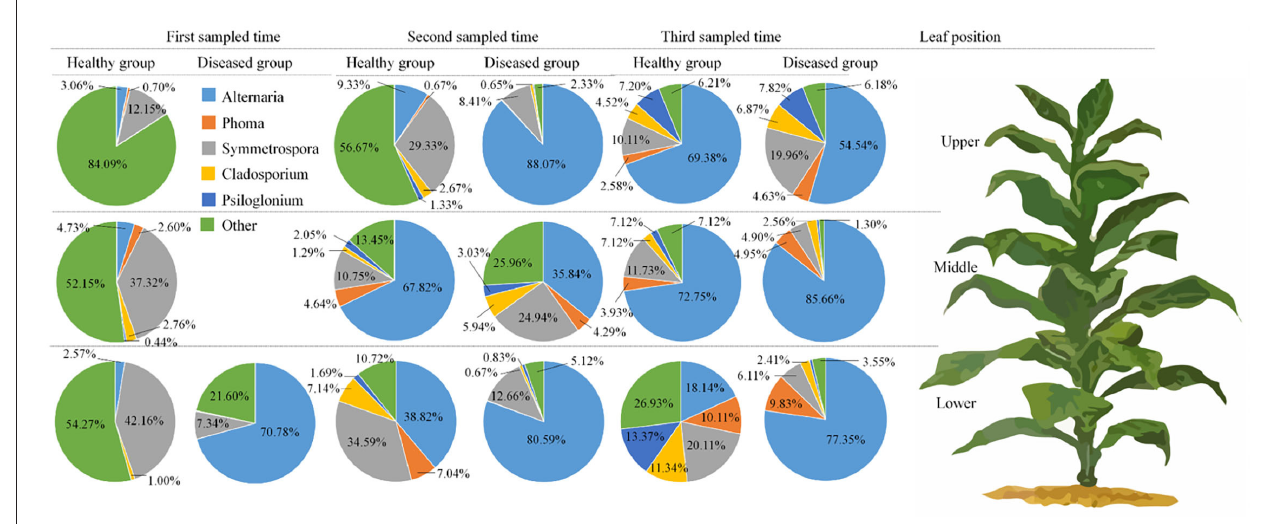
FIGURE 4 | Pie charts showing the relative abundance of top 5 fungal genus of Alternaria, Phoma, Symmetrospora, Cladosporium, Psiloglonium, and “others” in the three analyzed leaf positions and at three collecting